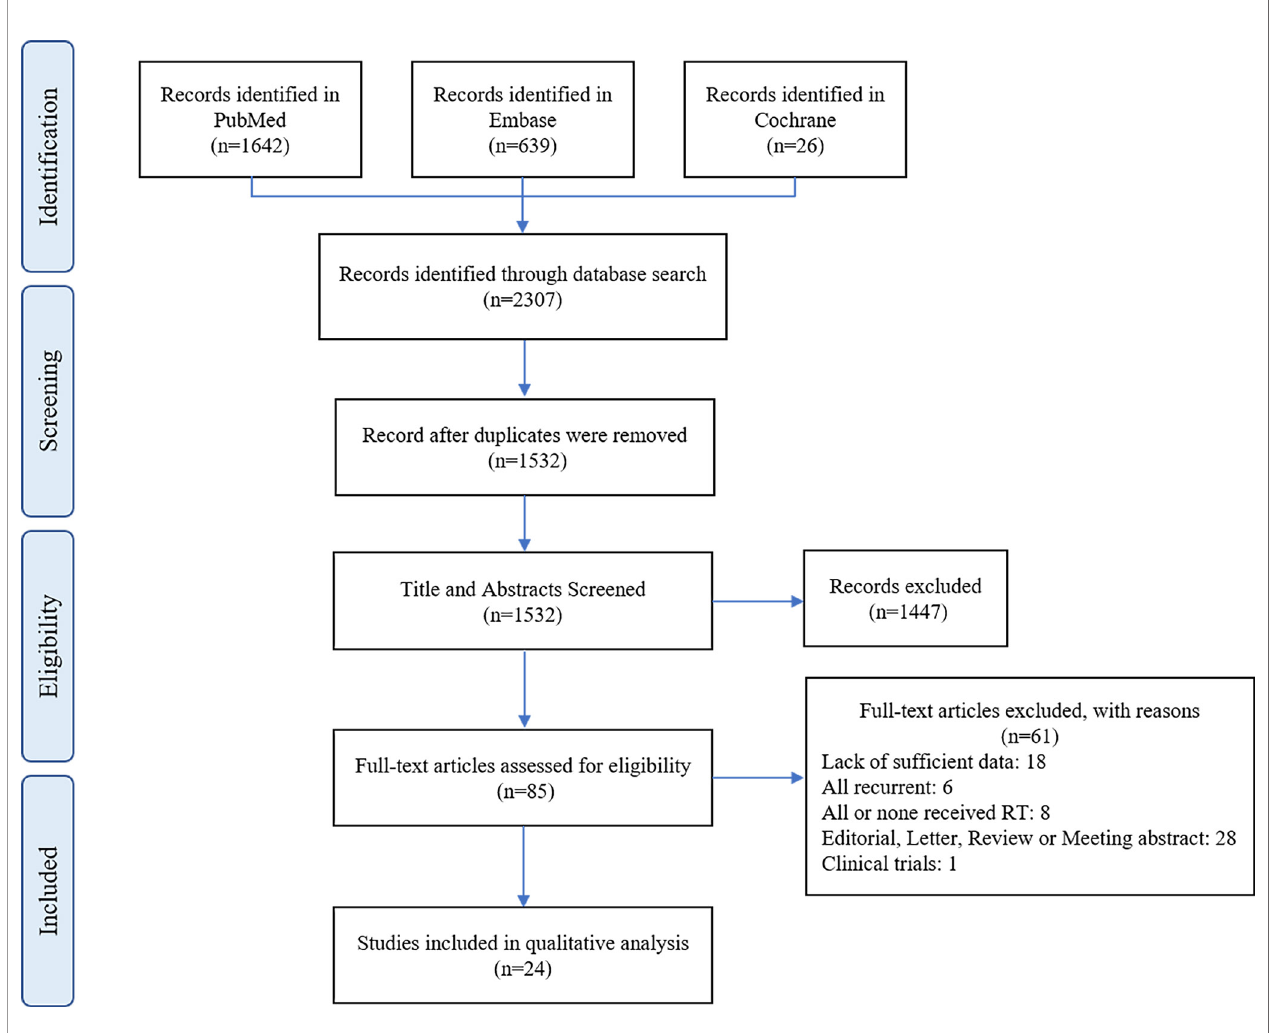
FIGURE 1 | The fl ow diagram of the selection process as per